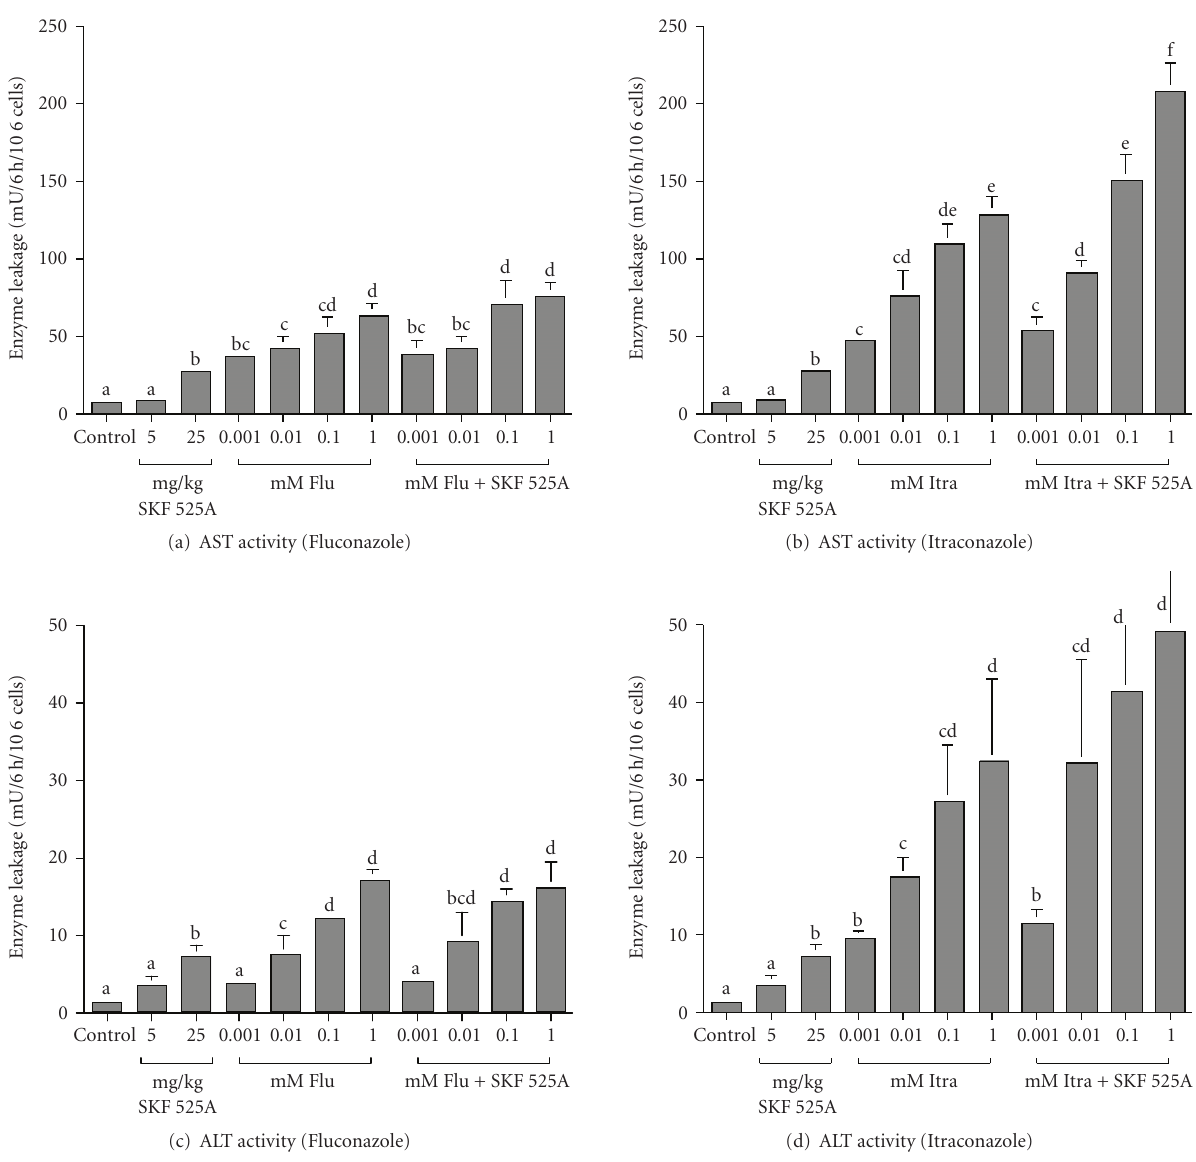
Figure 4: AST and ALT activities in rat hepatocytes exposed to various concentrations of itraconazole and fluconazole. a–d Means with di ff erent superscript di ff er significantly ( P < . 05). Values are mean ± sd of 3 separate